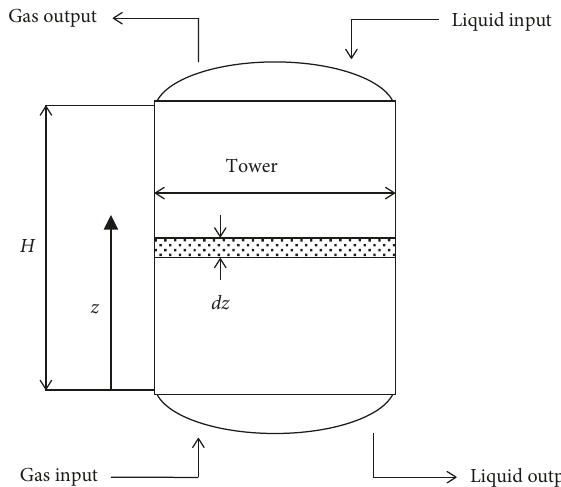
Figure 1: Absorption tower used for carbon dioxide